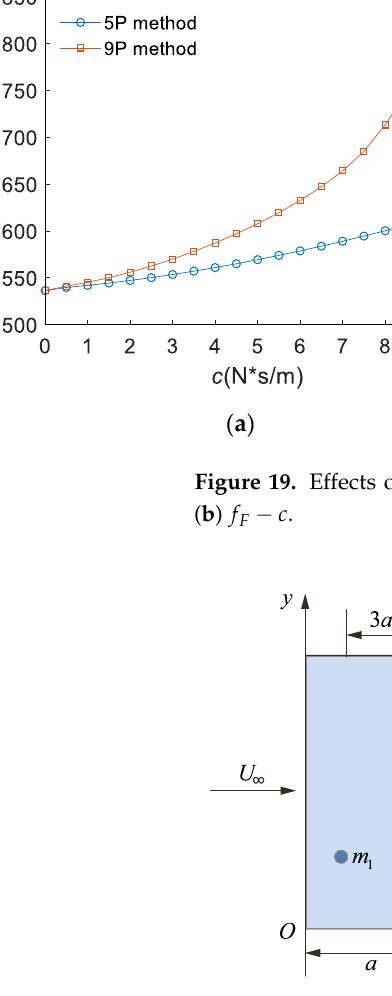
Figure 20. Two kinds of panels with different aspect ratio (QP): ( a ) a / b = 0.5 (AR1), ( b ) a / b = 2.0